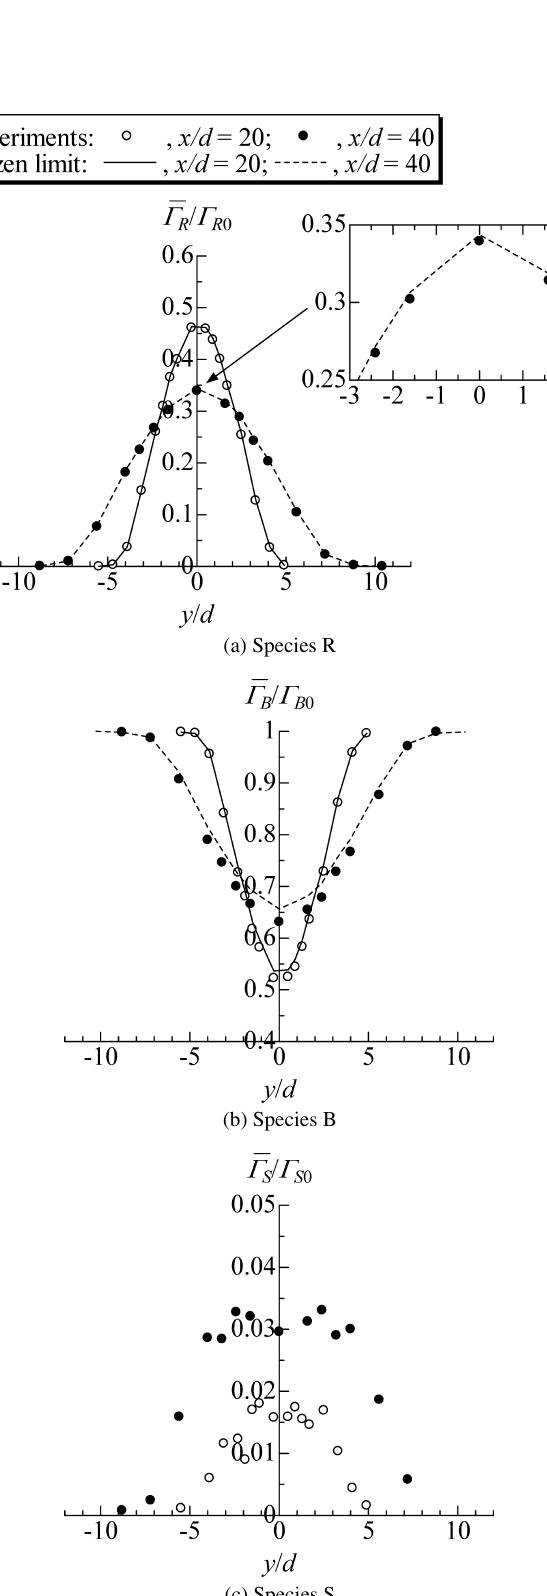
Fig. 6 Cross-streamwise profiles of mean